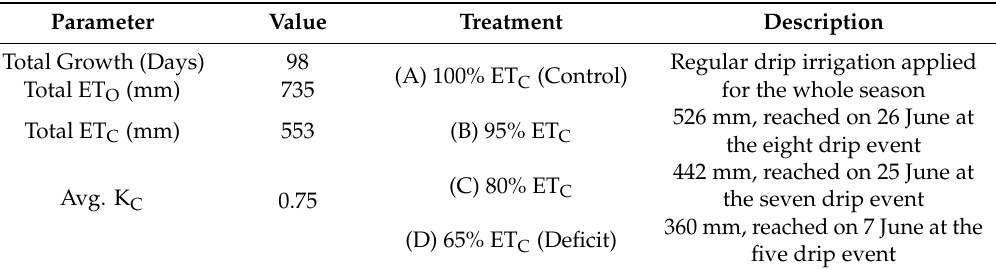
Table 5. List of irrigation treatments and